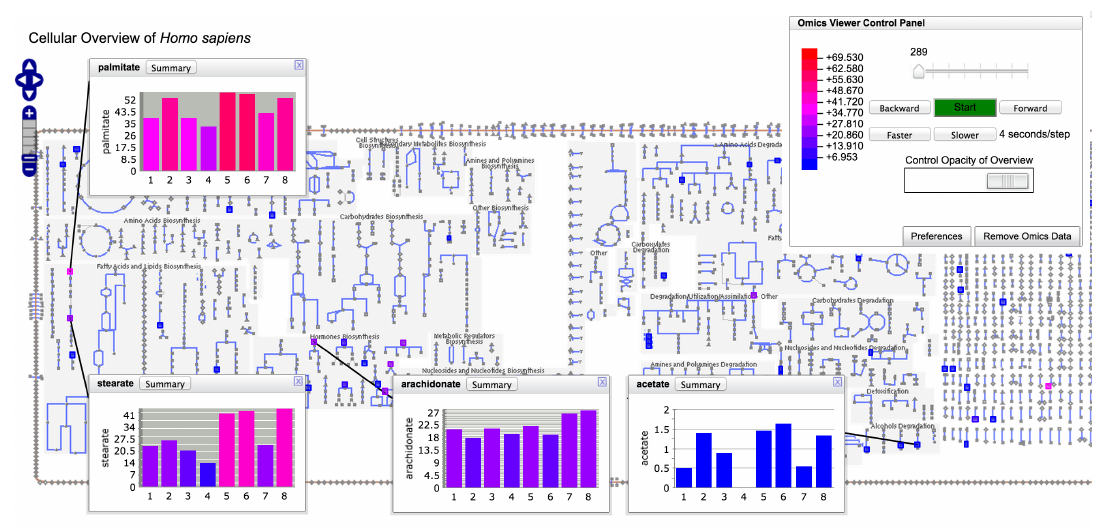
Figure 5. Human Cellular Overview diagram highlighted with metabolomics data. The Omics Viewer Control Panel in the upper right shows the mapping of metabolomics concentration values to colors and allows the user to start, stop and change the speed of the animation. Data were derived from metabolomics data of Chen et al . acquired during a period of diabetic onset and respiratory syncytial virus infection. Data shown represent the daily mean of positive-mode LC-MS peak intensities computed from observed compound peaks in three technical replicates and scaled by a factor of 1e-6. The right side of the Cellular Overview has been omitted because of its